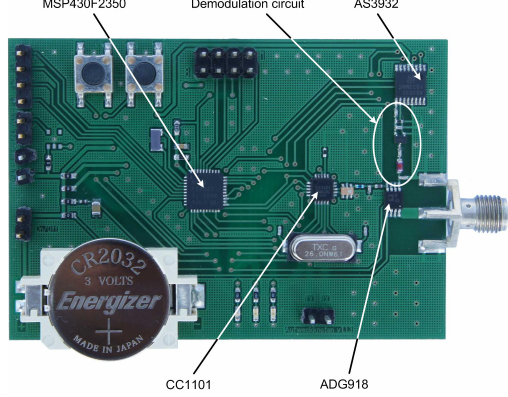
Figure 1. Photo of the assembled sensor node with wake-up re- ceiver.